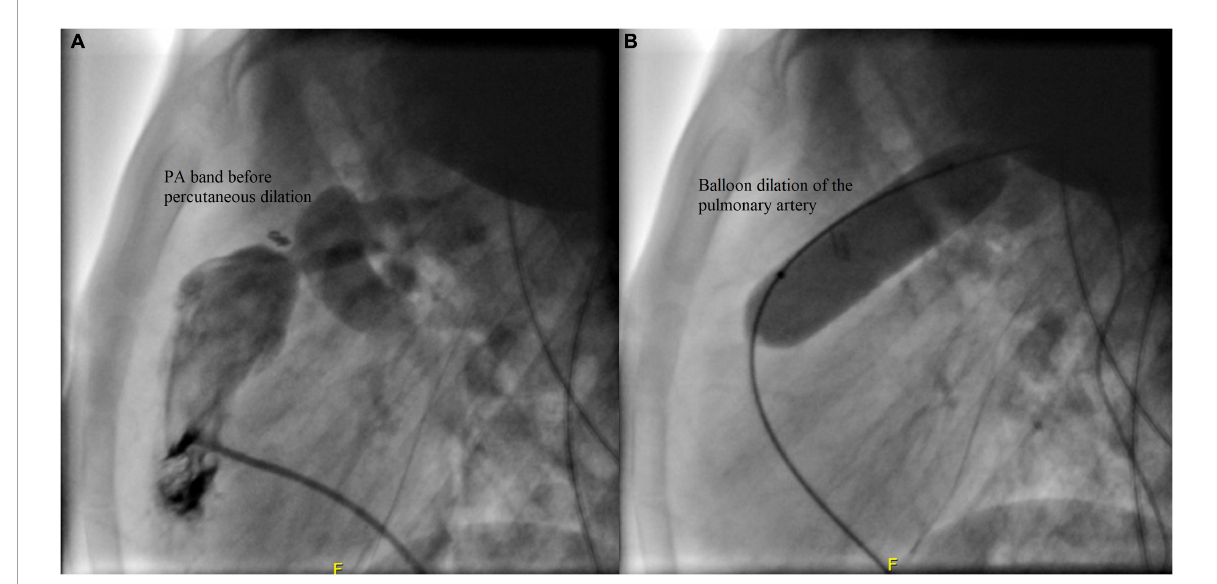
FIGURE5 Angiographic findings of Case II before (A) and after (B) the debanding